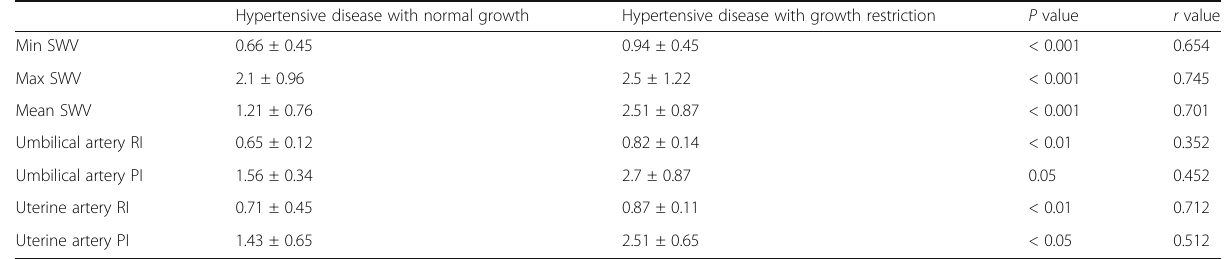
Table 3 Correlation between the mean SWV and Doppler indices in hypertensive disease (essential hypertension and preeclampsia/ eclampsia) with normal growth and with growth restriction Hypertensive disease with normal growth Hypertensive disease with growth restriction P value r